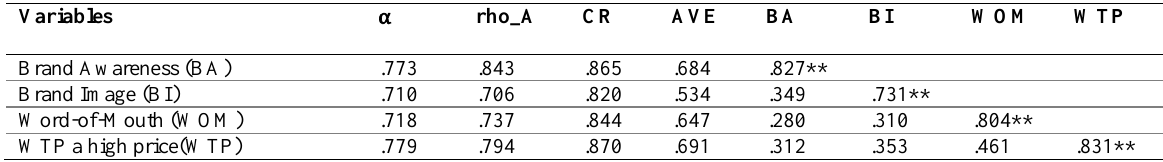
Table 3: Psychometric